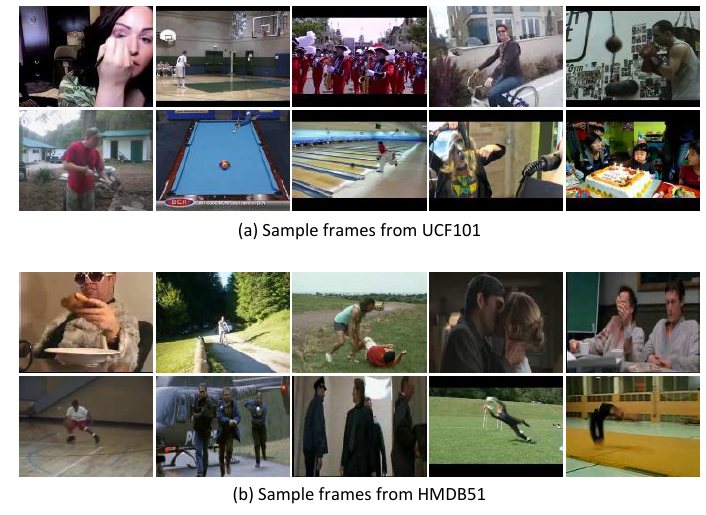
Figure 9. Sample frames from UCF101 and HMDB51.